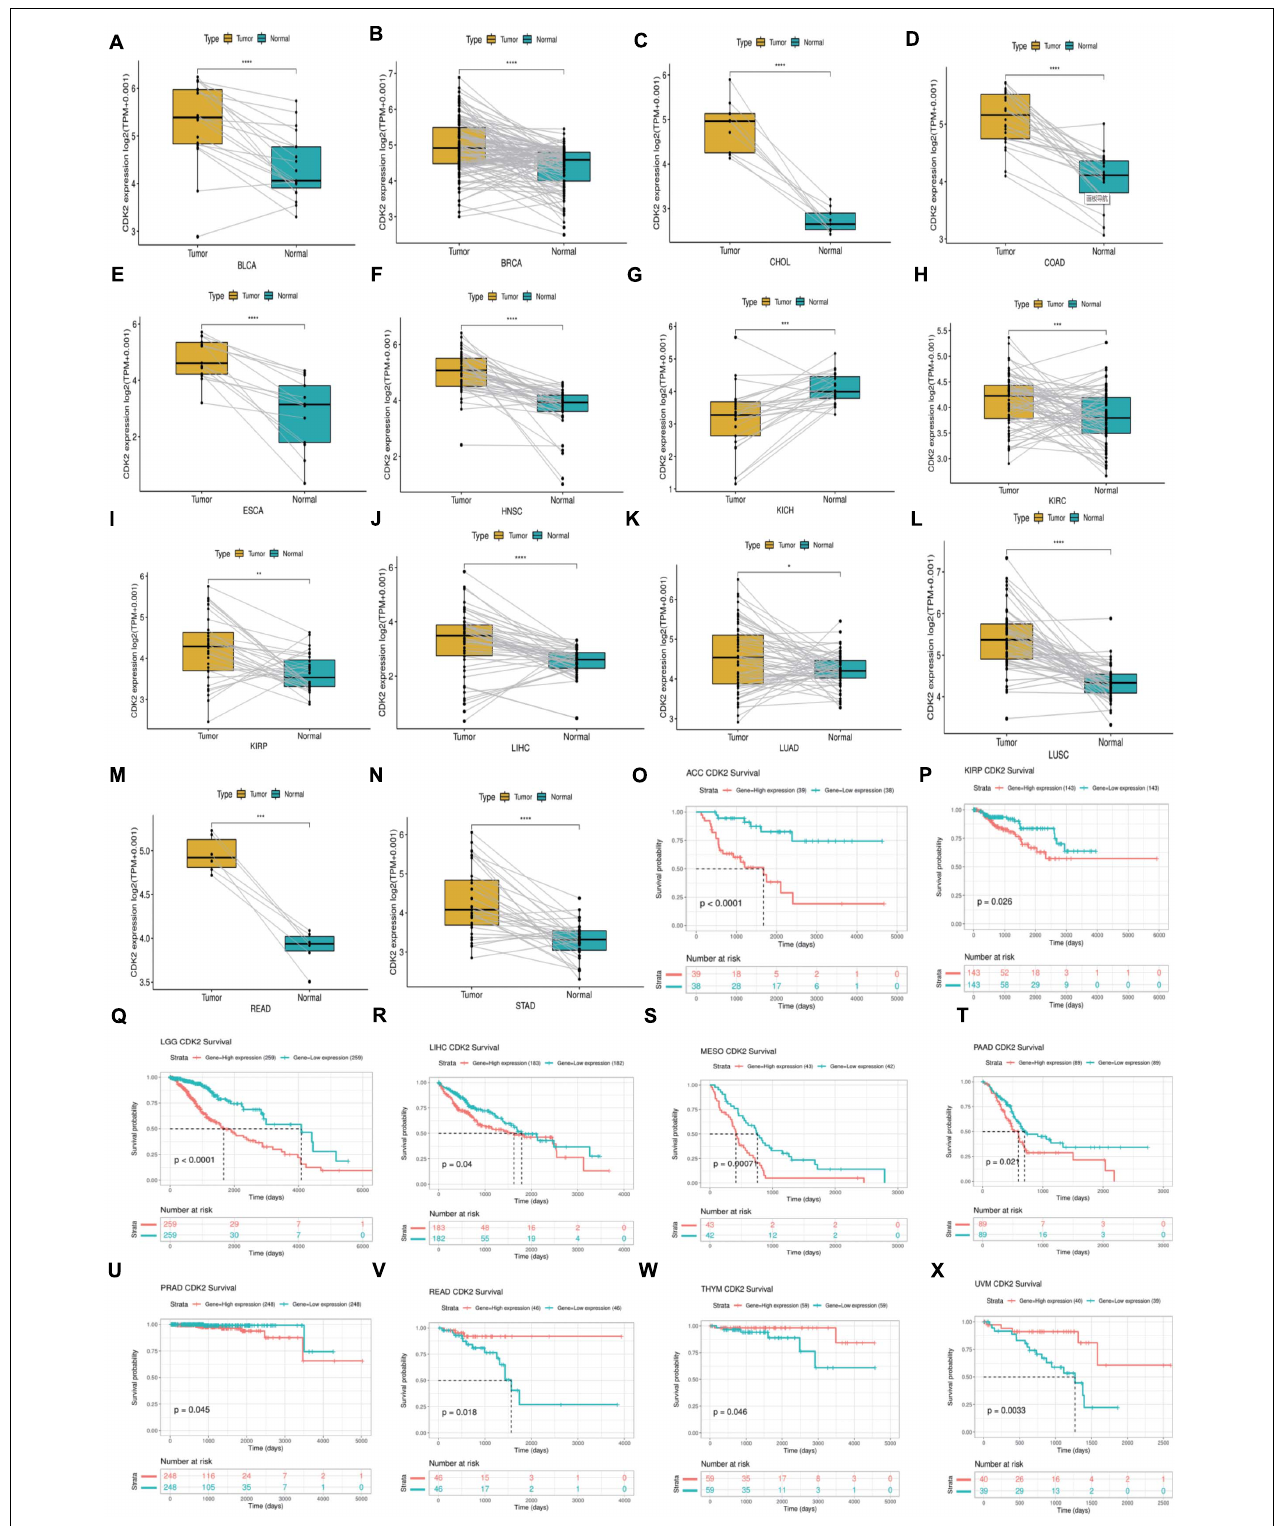
FIGURE 7 | The Paired expression and survival analysis of CDK2. (A–N) For different types of cancer, we carried out paired differential expression of CDK2. (O–X) In 10 kinds of cancers, the expression of CDK2 was related to the prognosis of patients. (* P < 0.05, ** P < 0.01, *** P < 0.001, **** P < 0.0001).